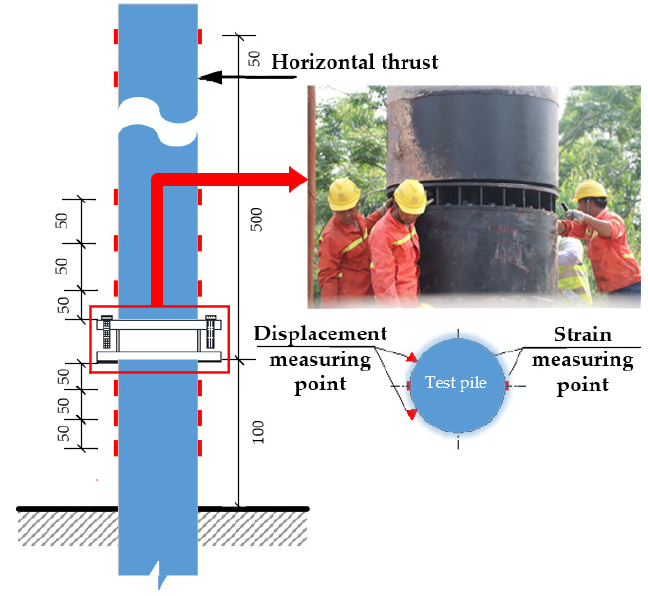
Figure 6. Layout diagram of measuring points in the reliability test of pile–column connection.